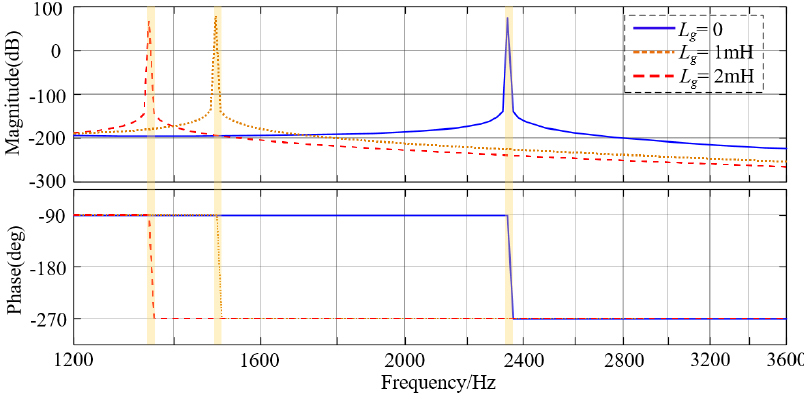
Figure 4. Bode diagram of G 0 .